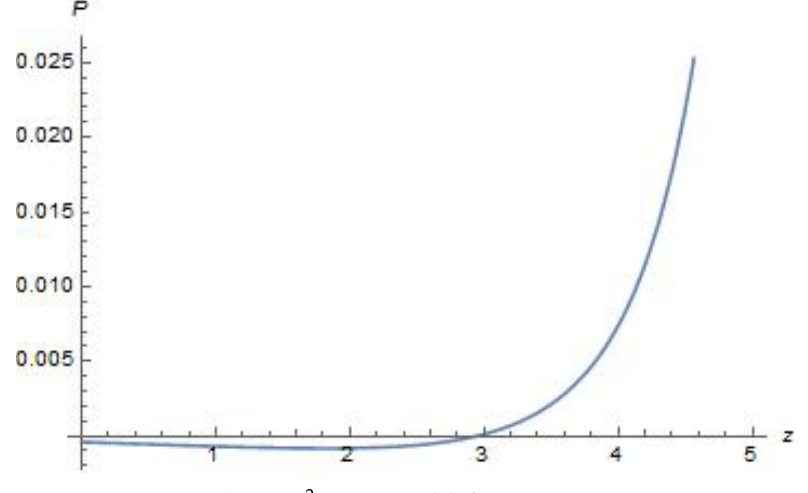
Figure 9. Pressure p (in Gyr − 2 ) against redshift z .